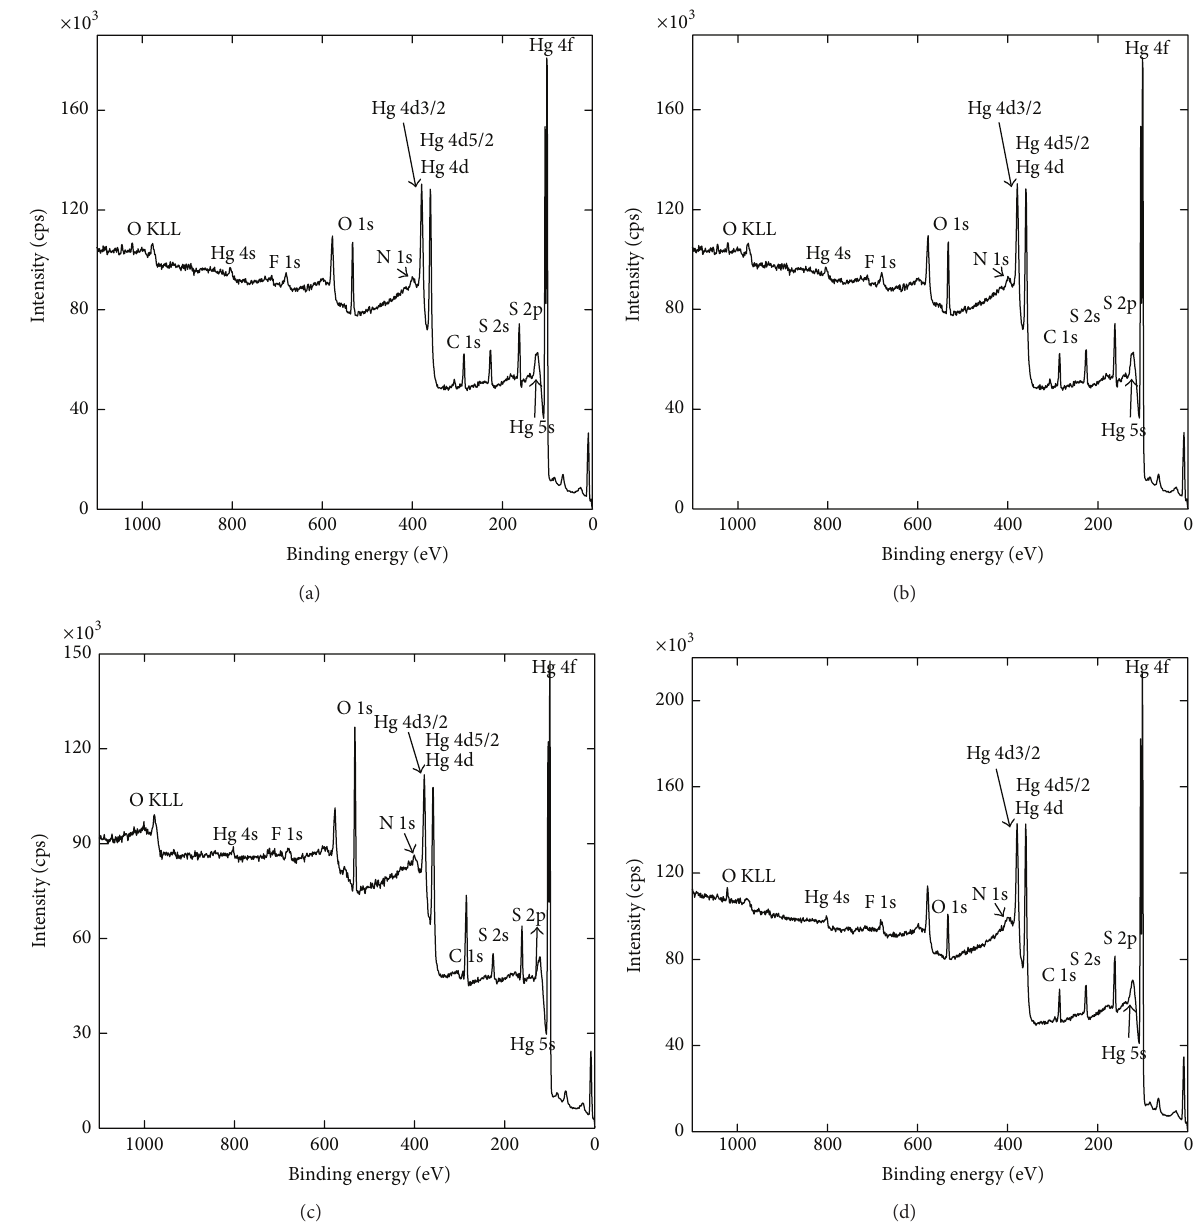
Figure 2: Full XPS spectra of Zuota samples. (a) S1; (b) S2; (c) S3; (d)